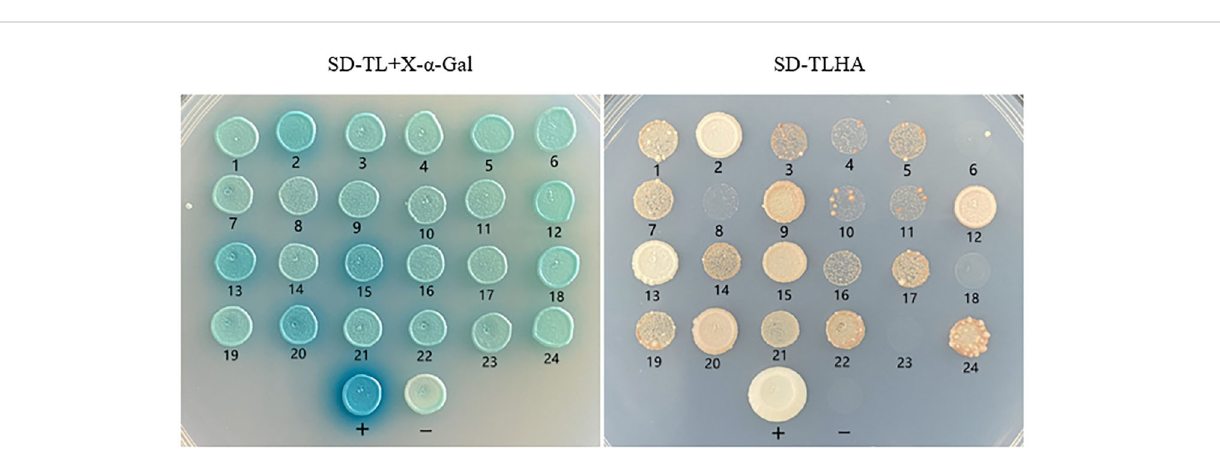
FIGURE 6 Yeast two-hybrid assay of Bf APX proteins in B fuscopurpurea stress response. SD-TL, SD/-Leu/-Trp. SD-TLH, SD/-Leu/-Trp/-His. SD-TLHA, SD/-Leu/- Trp/-His/-Ade (+ X - a -